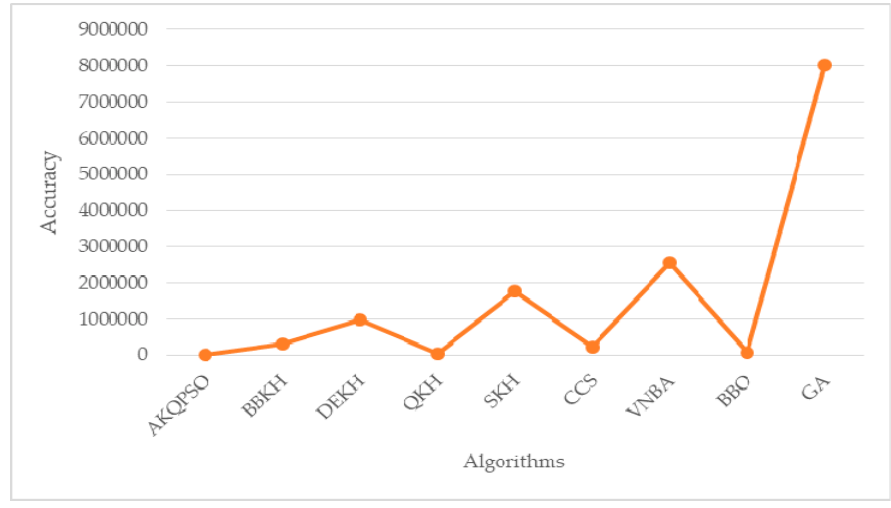
Figure 2. Accuracy of AKQPSO and other algorithms on all problems.